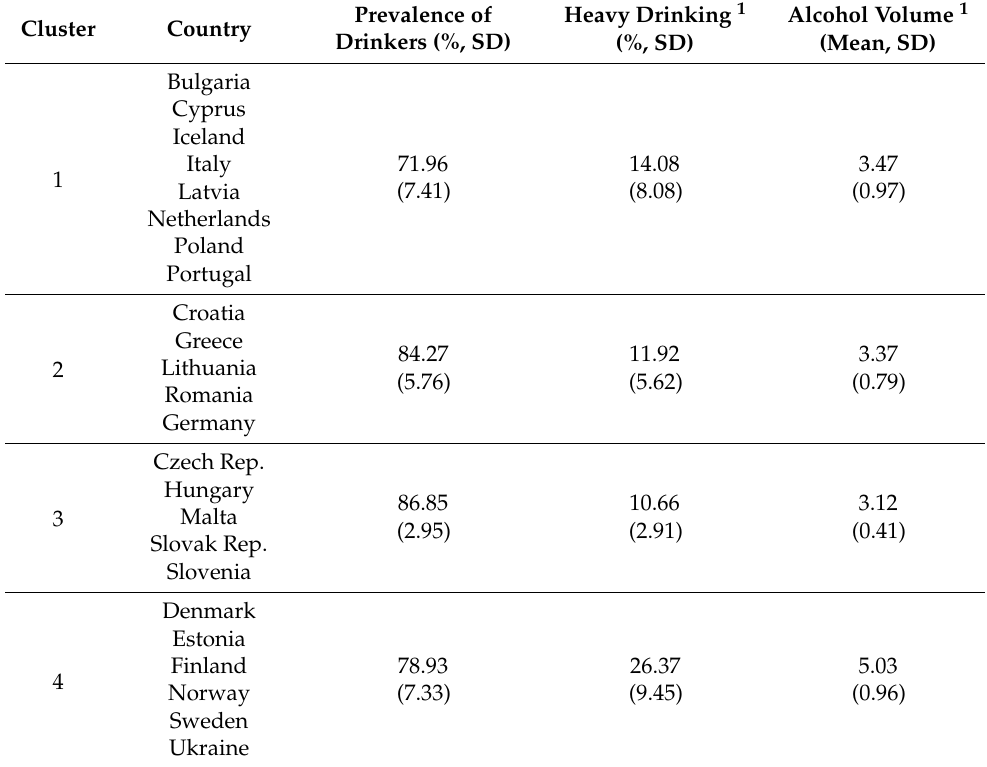
Figure 3. Geographical map of counties clustered by trends in beverage choice across the observation period (1999–2019) for girls ( left ) and boys ( right ). Table 3. Clusters by country and indicators of drinking for